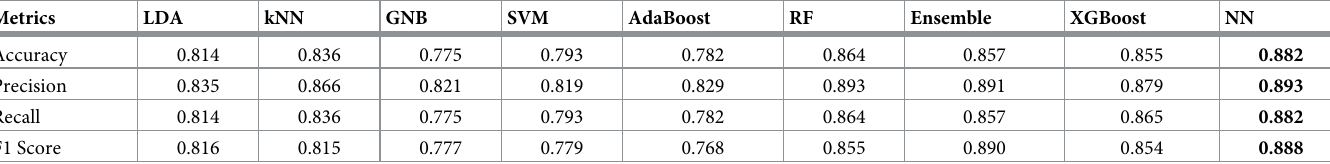
Table 5. Classification accuracy obtained using selected handcrafted (LBP + HOG + GLCM) and radiomic feature combinations. Metrics LDA Accuracy Precision